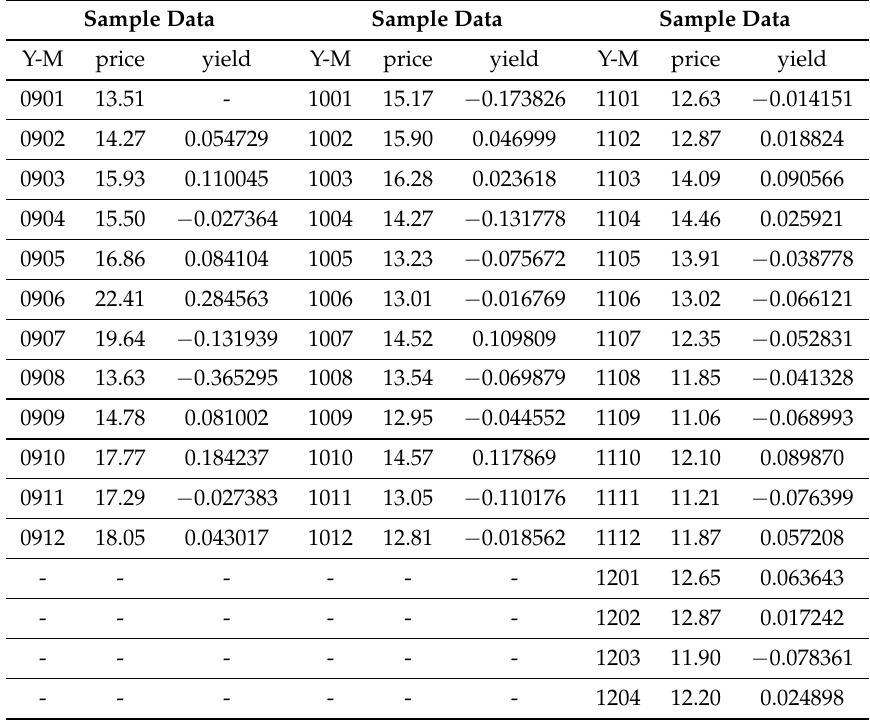
Table 7. Sample data year and month closing price yield.